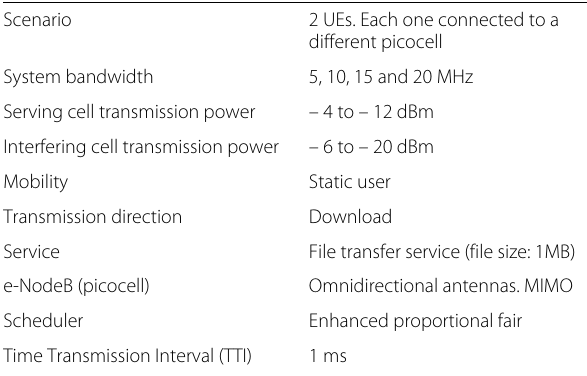
Table 1 Configuration of the